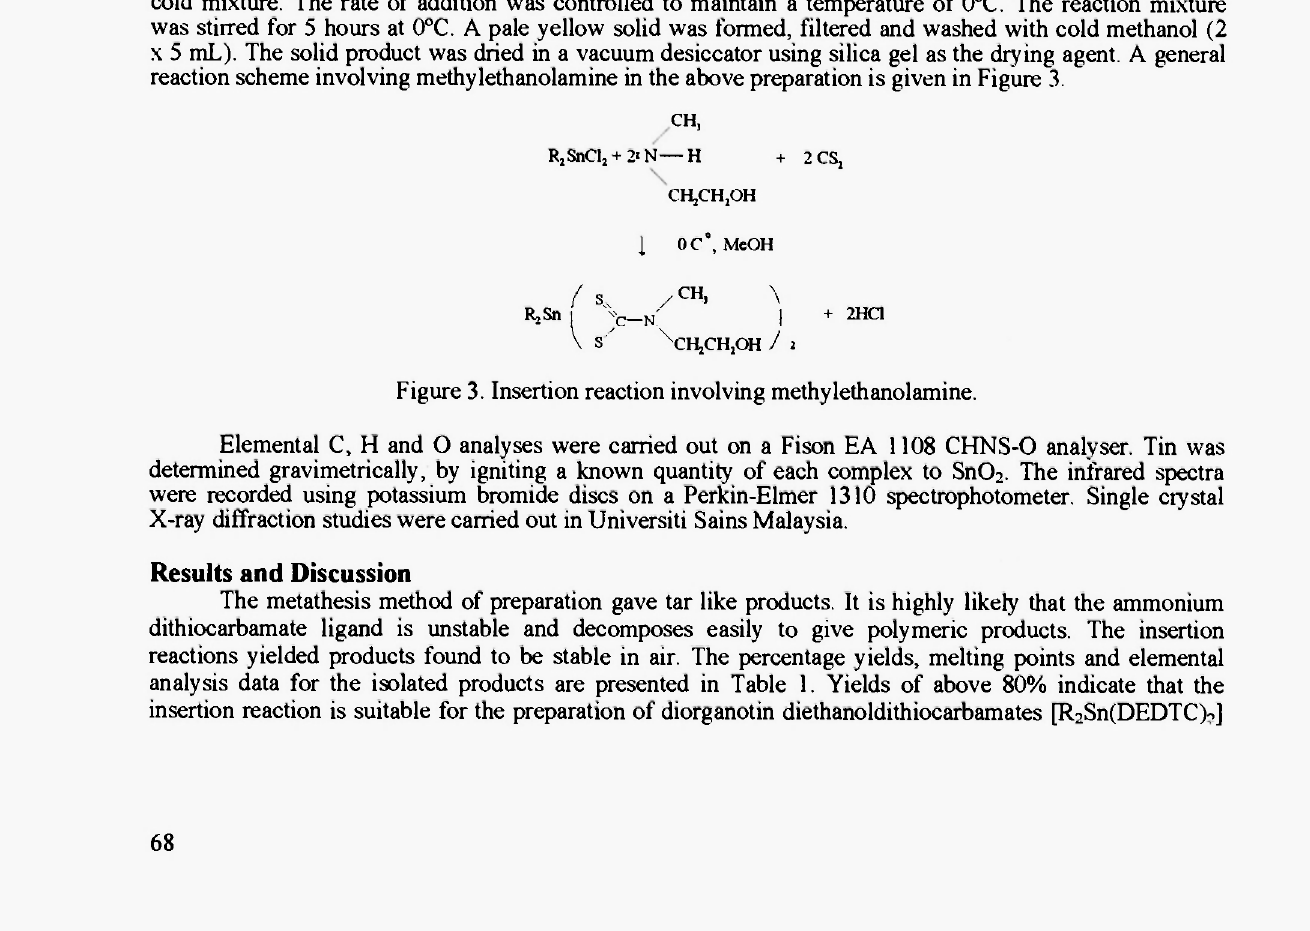
Figure 2. Metathesis reaction.